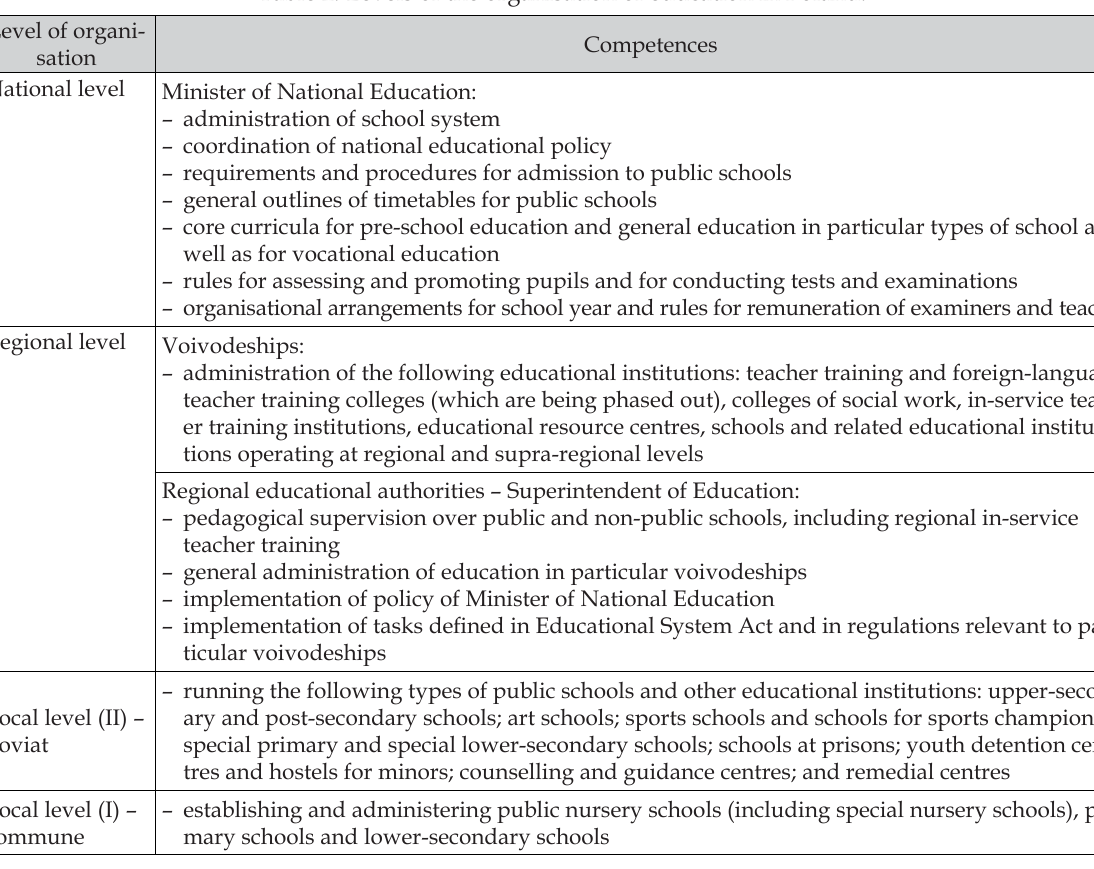
Table 2. Levels of the organisation of education in